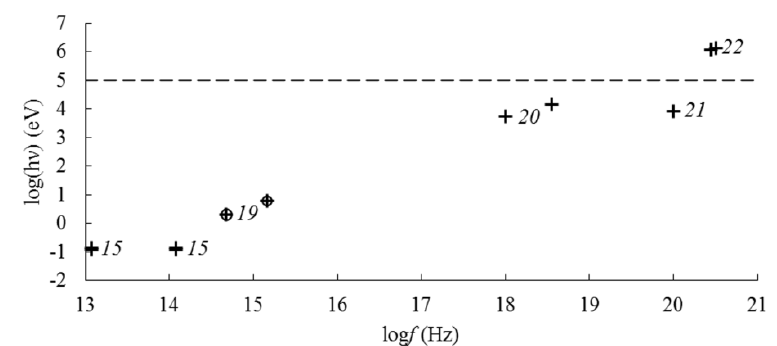
corresponds to a solid state, “ ○ ” corresponds to a liquid state. The dashed line corresponds to the threshold level of change in the crystalline structure.